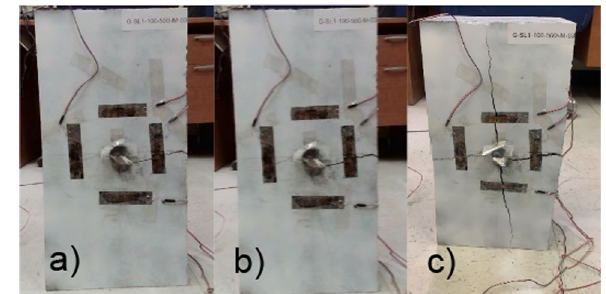
Fig. 4 Slab G-SL1-100-500-M-01 a At time t time t 18 c Complete breakage at time t 24